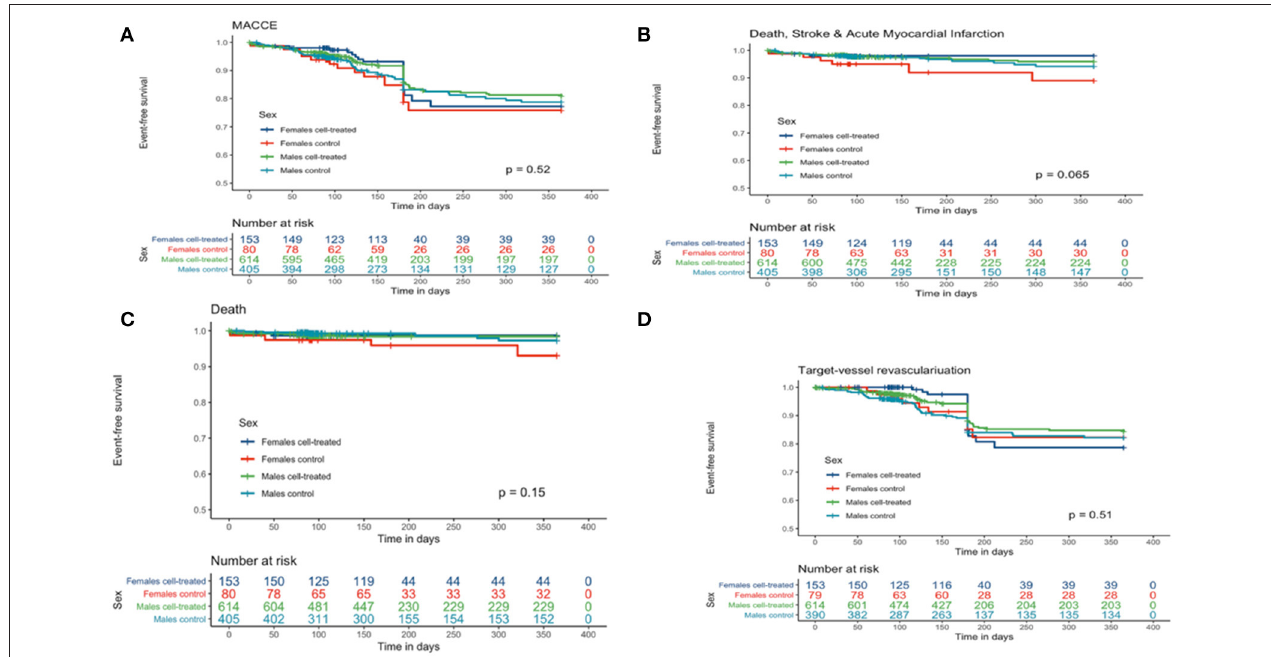
FIGURE 1 | Kaplan-Meier curves for clinical outcomes of women and men in cardiac regenerative studies after acute myocardial infarction. (A) Major adverse cardiac and cerebrovascular event(s) (MACCE), including all-cause death. (B) Combined hard clinical endpoint (all-cause death, stroke, and acute myocardial infarction). (C) All-cause death. (D) Target vessel